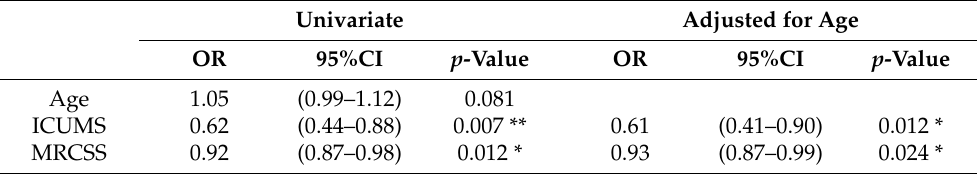
Table 4. The odds ratio of a Barthel index scored less than 100 based on age, ICUMS and MRCSS.